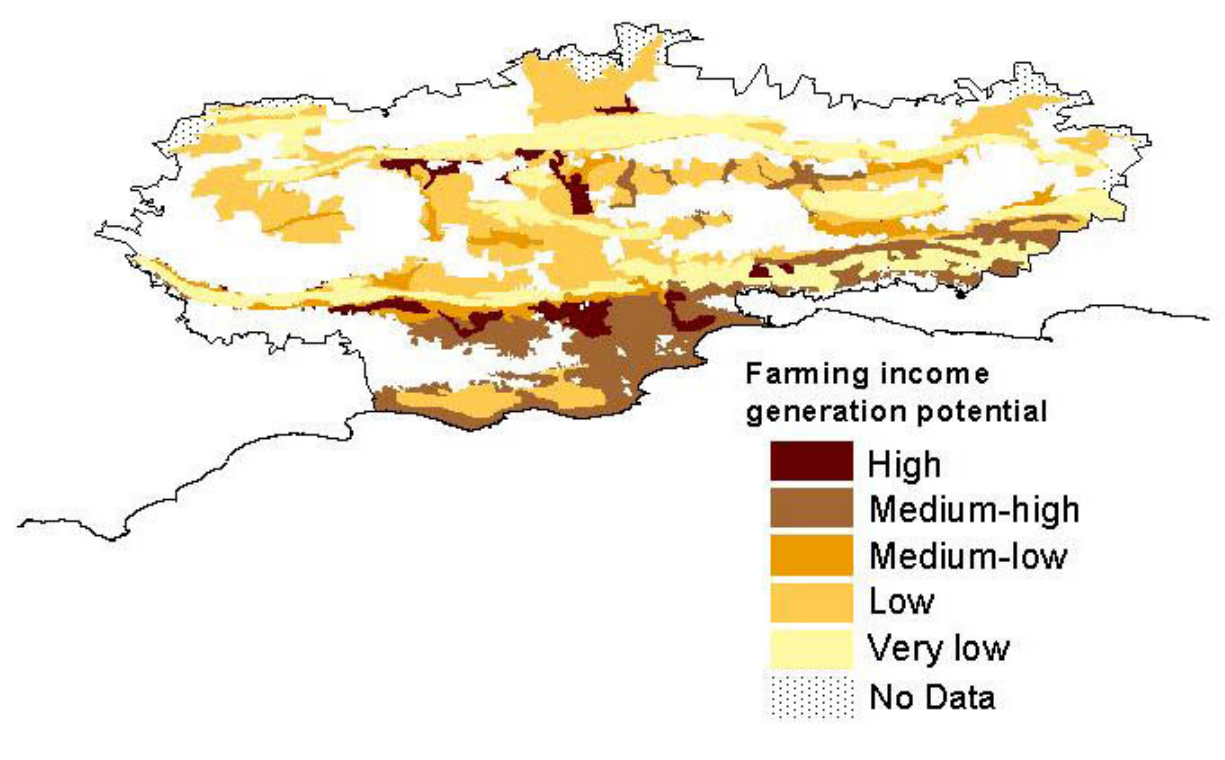
Fig. 6. The distribution of farming income generation potential within the corridor